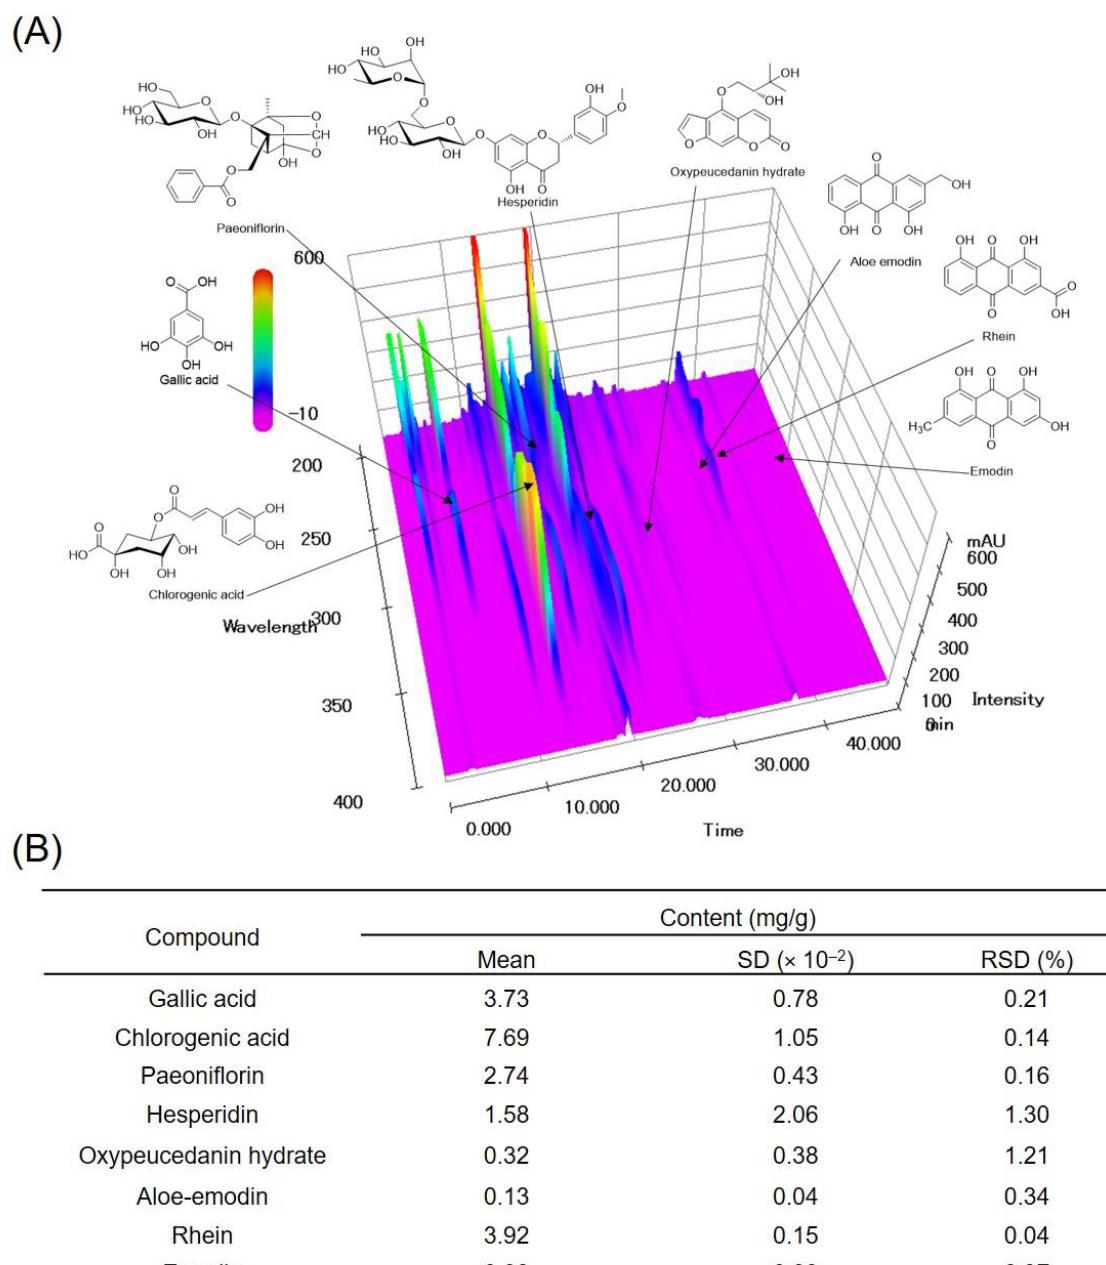
Figure 1. Three-dimensional HPLC-PDA chromatogram ( A ) and the contents of eight marker components in SBH. Repeatability was confirmed by the RSD (RSD (%) = standard deviation (SD)/mean × 100%) ( B ). SD, standard deviation; RSD, relative standard deviation.